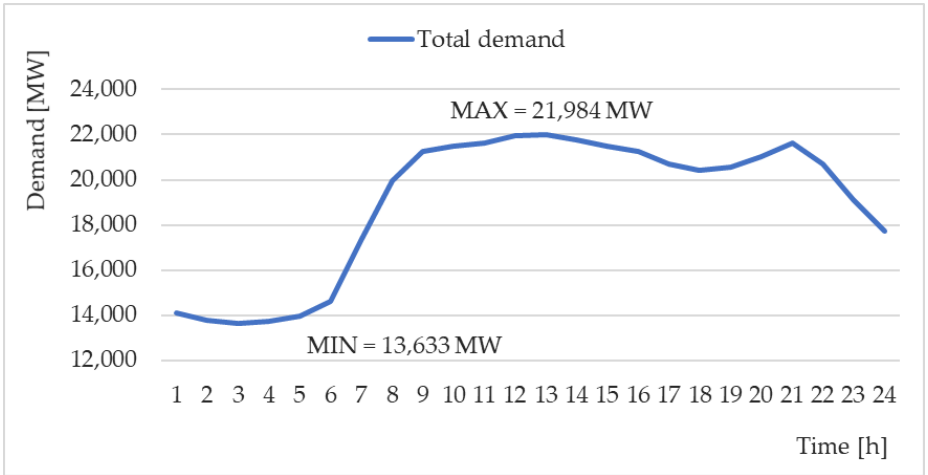
Figure 4. The assumed fixed load (demand) profile. Data source [25].